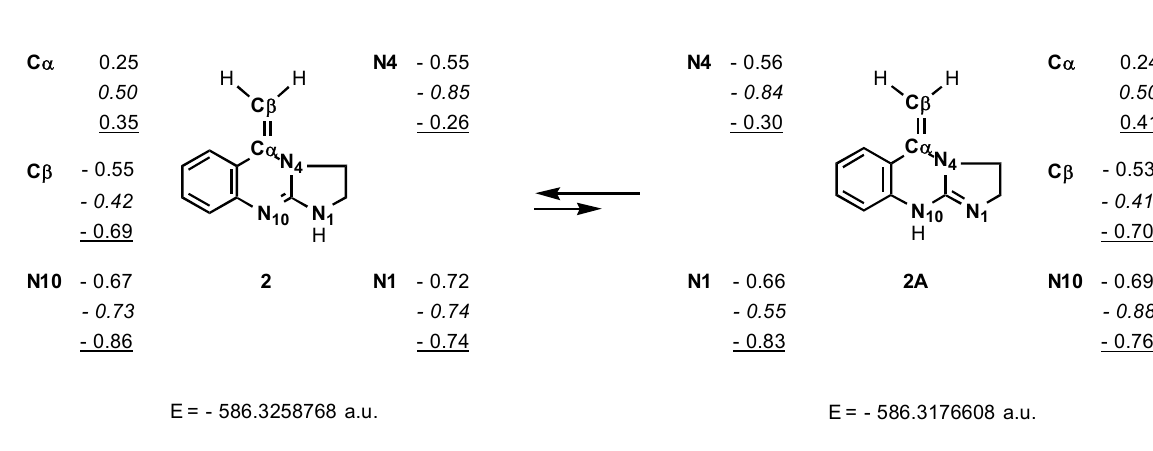
Figure 3. Calculated [7] natural charges (plain), charges from Mulliken population analysis (italic) and atomic charges from electrostatic potential (underlined) for selected atoms of 2 and 2A